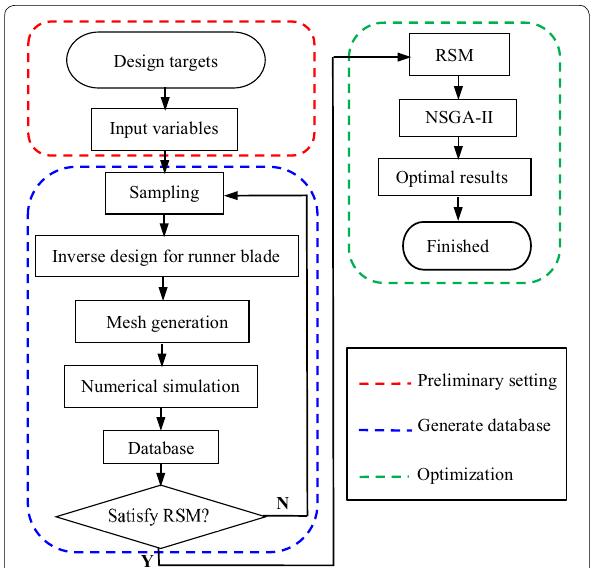
Figure 5 Flow chart of the multi‑optimization